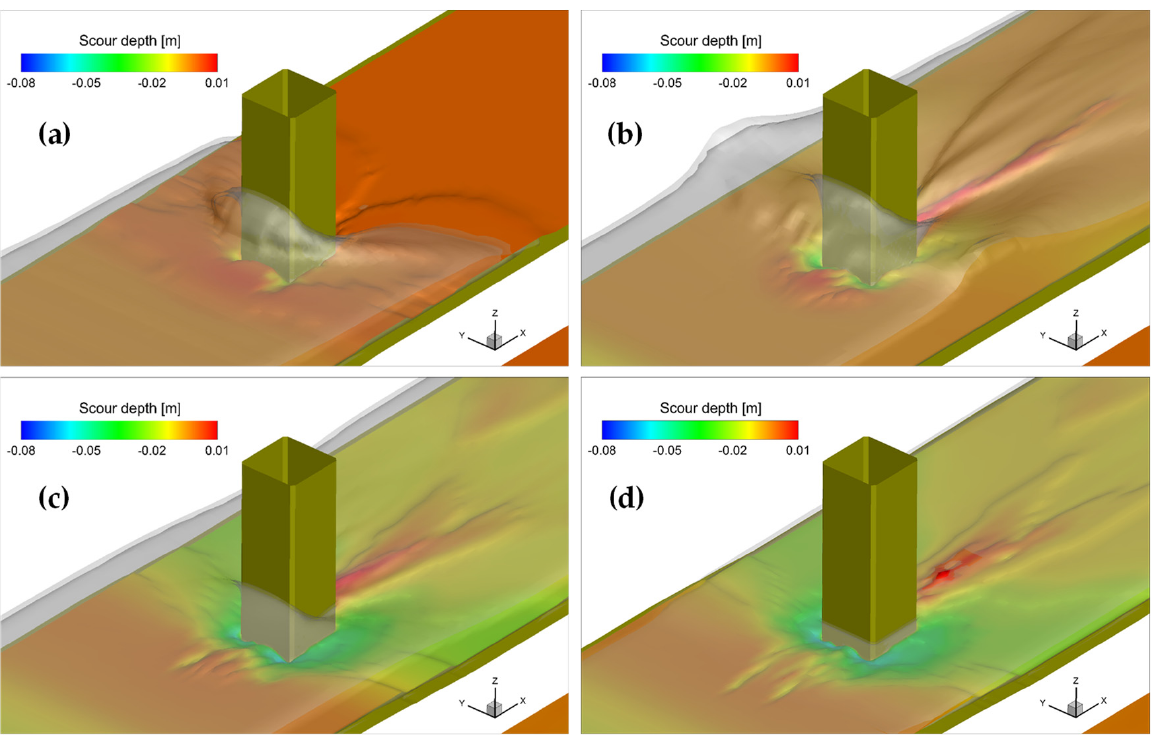
Figure 8. Simulated scour morphology around structure at the moments of ( a ) t 1 , ( b ) t 2 , ( c ) t 3 , and ( d ) t 4 .